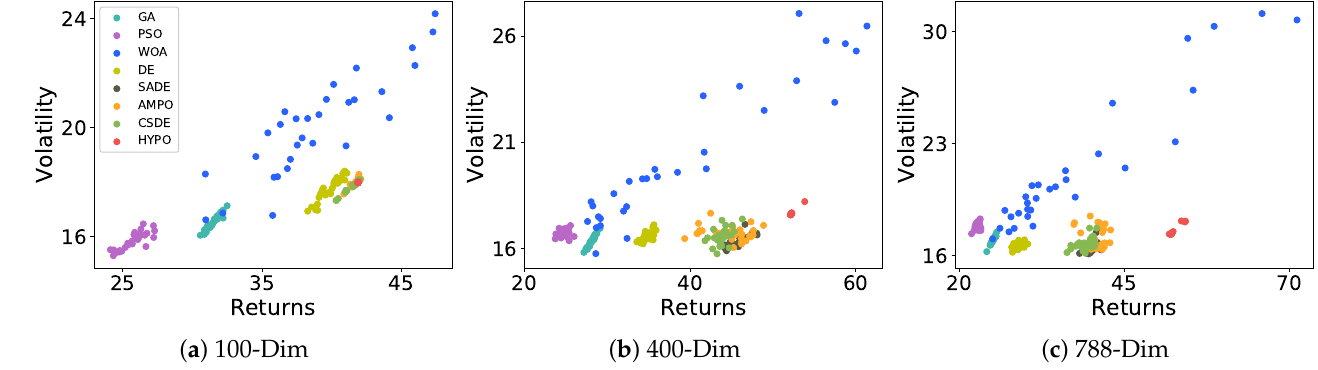
Figure 8. Visualization of Mean-variance Distribution on the Mixed Market